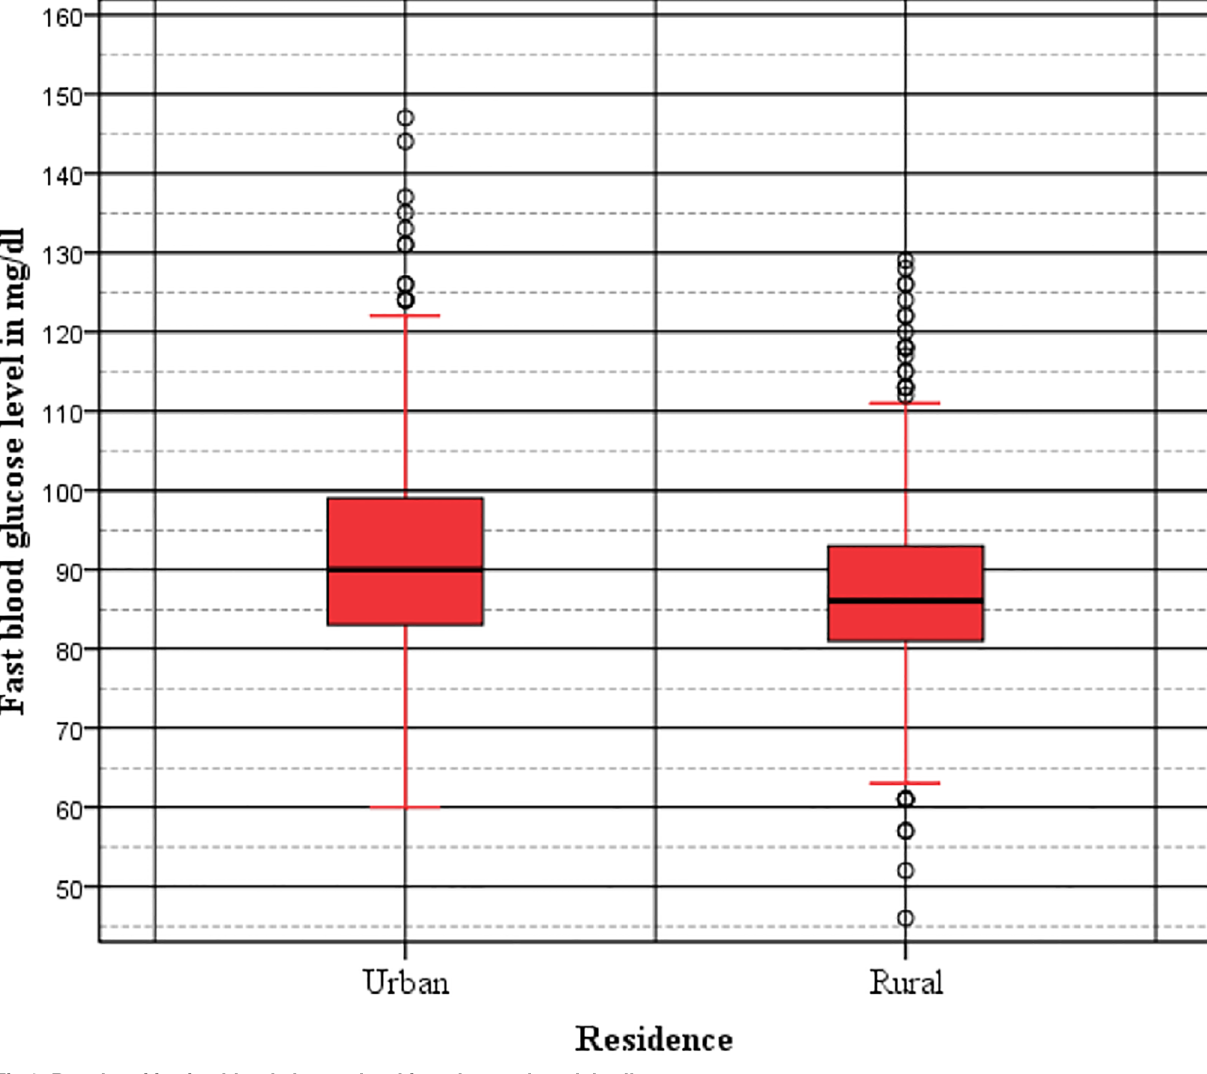
Fig 1. Boxplot of fasting blood glucose level for urban and rural